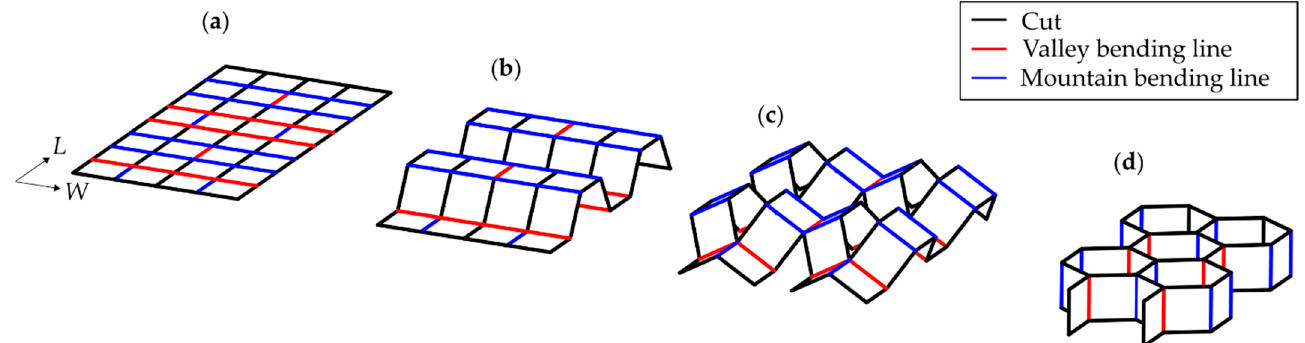
Figure 1. ( a ) Flat film sheet with designated bending lines, ( b ) applying bends in the W-direction, ( c ) applying cuts and bends in the L-direction, and ( d ) final cellular structure. ( c ) applying cuts and bends in the L-direction, and ( d ) final cellular